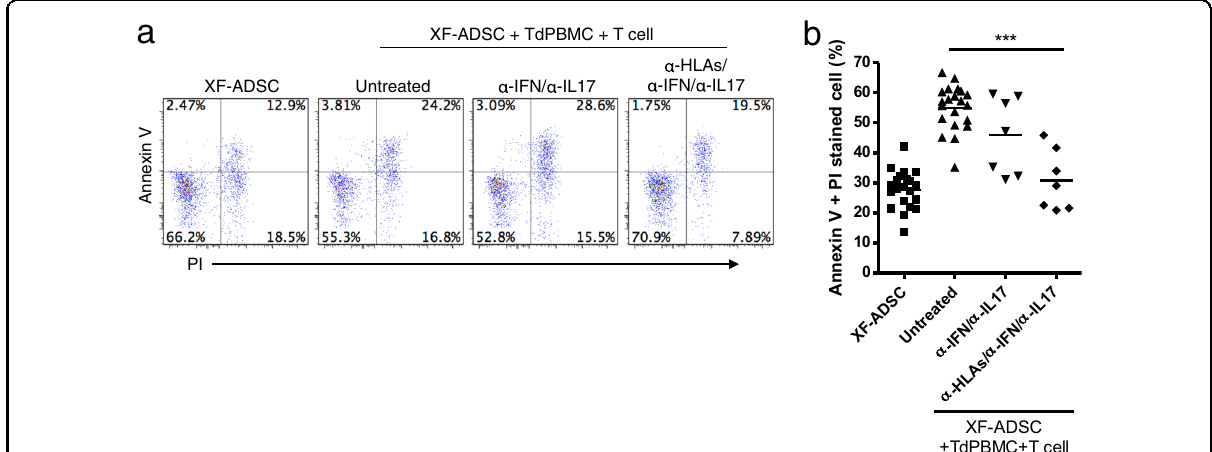
Fig. 5 Human leukocyte antigens (HLAs) on allogeneic adipose-derived mesenchymal stem cells grown in xeno-free medium (XF-ADSCs) are the major cause of T cell-mediated cytotoxicity. a XF-ADSCs were subjected to allogeneic antigen stimulation for 21 – 24 days with antibodies against interferon- γ (IFN- γ ), interleukin (IL)-17A, HLA-ABC, HLA-DR, and HLA-DQ (all at 1 μ g/ml) in xeno-free medium containing 5% autologous serum. The effects of the XF-ADSCs with antibodies on T cell-mediated cytotoxicity were evaluated in comparison with those of the XF-ADSCs not containing antibodies. For cell death analysis, the collected XF-ADSCs were stained with anti-CD73 and anti-CD90 antibodies, annexin V, and propidium iodide (PI), and the cell death rate was analyzed by fl ow cytometry. b Graphical representation of XF-ADSC death corresponding to ( a ) ( n = 21 (untreated), n = 7 (for each sample)); *** p < 0.001. Td-PBMCs T cell-depleted T cell-depleted peripheral blood mononuclear